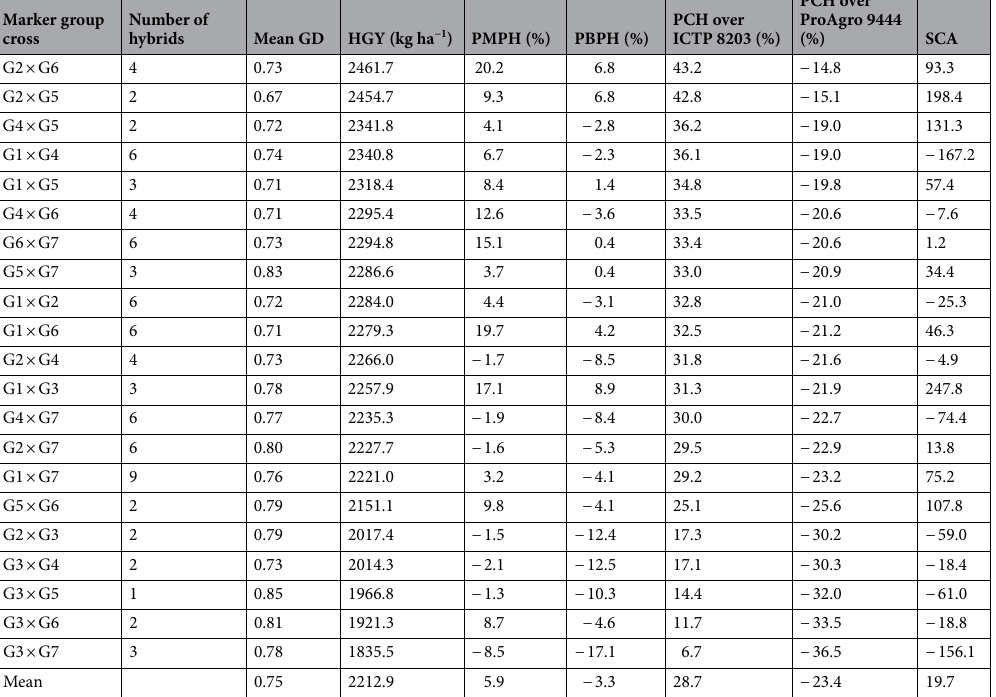
Table 6. Genetic distance (GD), hybrid yield, yield heterosis (PMPH, PBPH and PCH) and specific combining ability (SCA) for 21 marker group crosses in pearl millet across three locations. HGY Hybrid grain yield, PMPH Panmictic mid-parent heterosis, PBPH Panmictic better parent heterosis, PCH Panmictic commercial heterosis, SCA Specific combining ability.